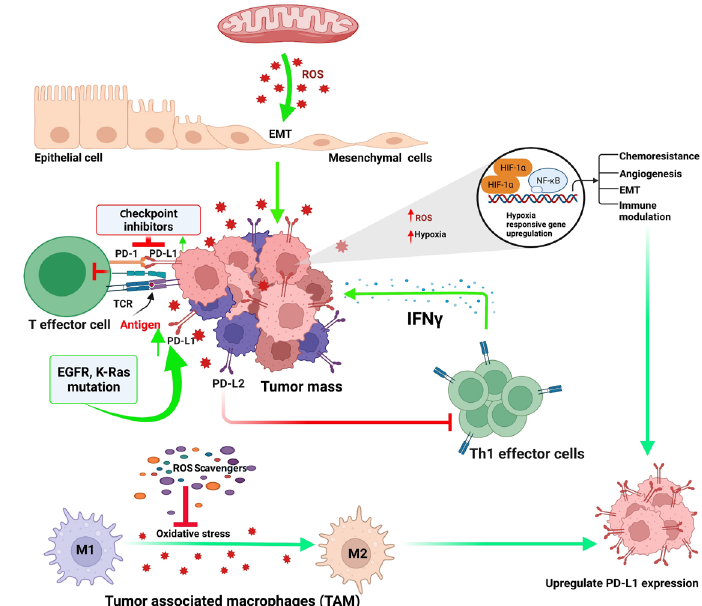
Figure 5. Regulatory links between oxidative stress and check point inhibitors in tumor microenvironment. TCR: T-cell receptor; Th1: T helper type 1; EGFR: epidermal growth factor